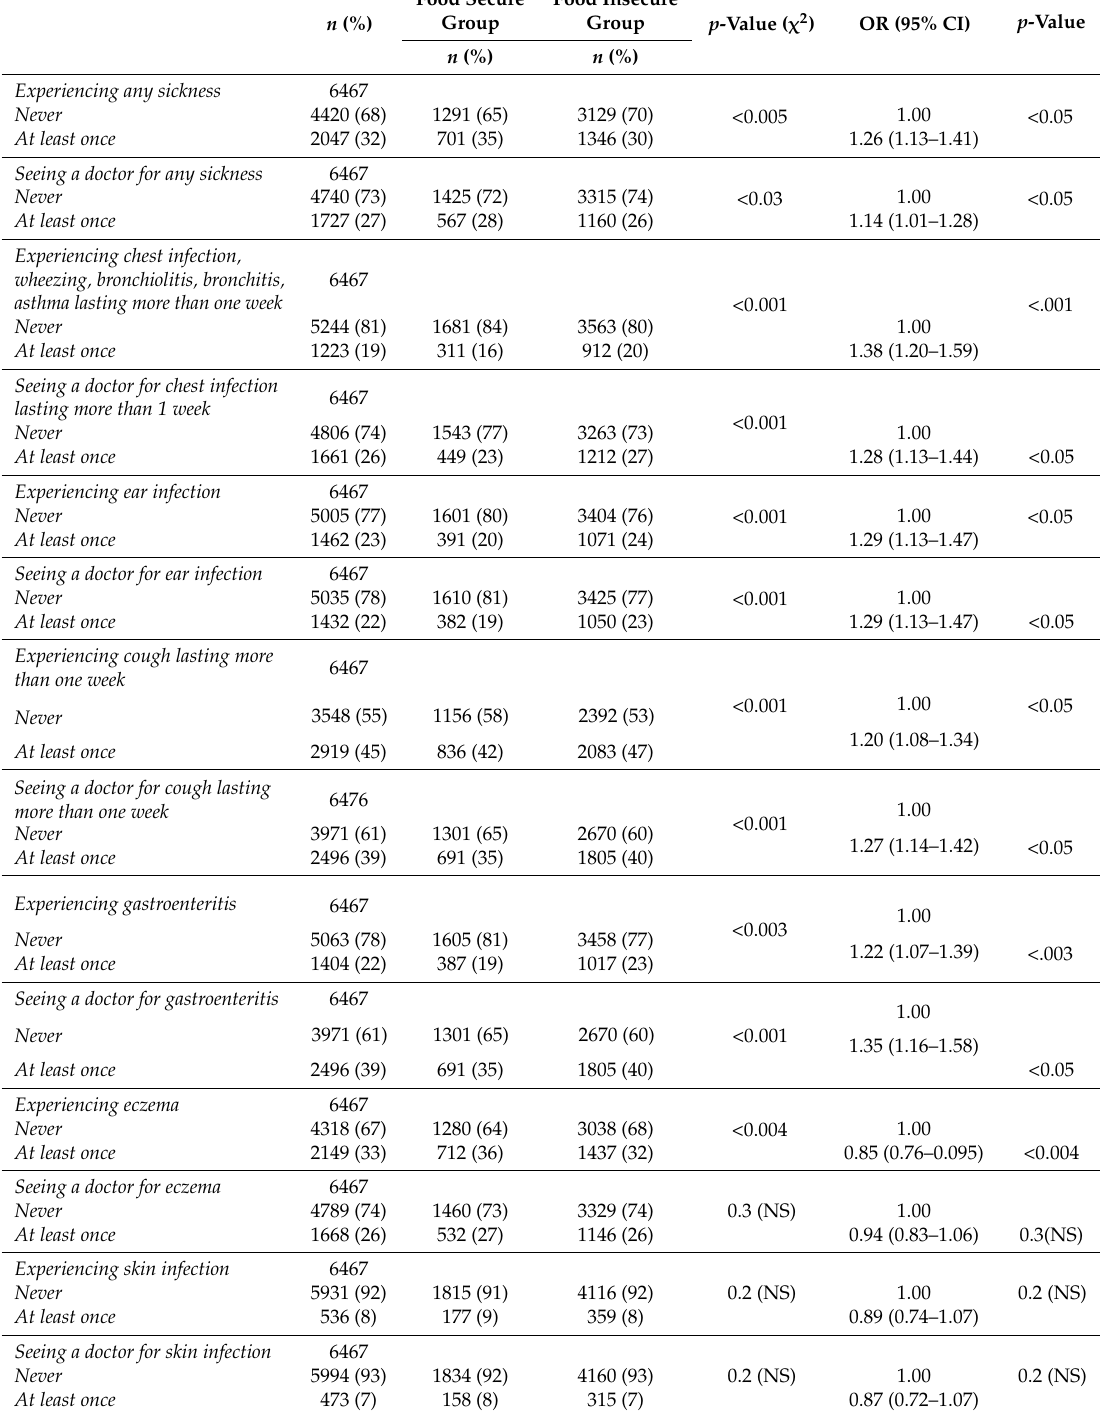
Table 7. Adjusted odds ratios a for the association of food security status with health outcome in nine month old